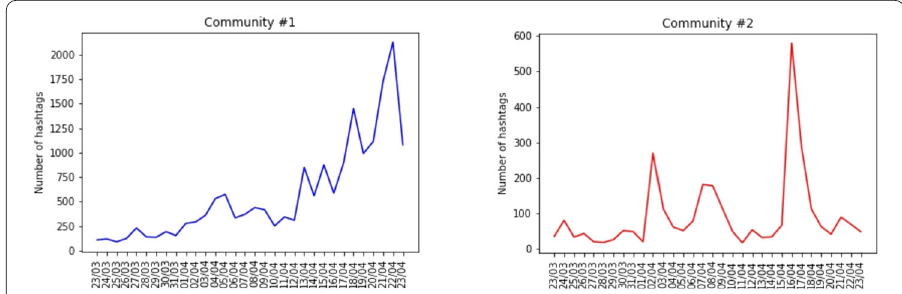
Figure 7 Temporalevolutionofthenumberofhashtagspublisheddaytodayandbelongingtothetwo d/misinformationcommunitiesdescribedinthetext . The various peaks can be related to various offline